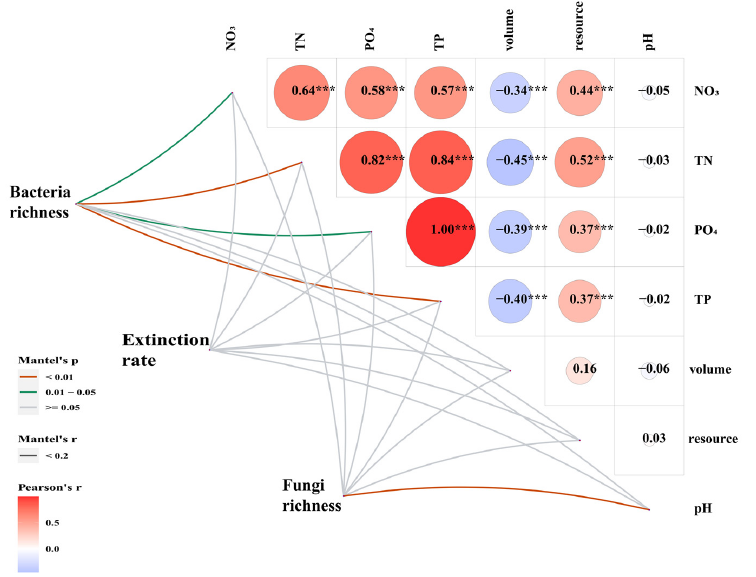
Figure 6. Mantel test correlation plot. The heat map shows the Pearson correlation between the environmental factors; the thickness of the line represents the size of the Mantel test correlation coefficient; the color of the line indicates the p -value of the Mantel test. * p < 0.05, ** p < 0.01, *** p < 0.001. In both treatment groups, microbial taxa with high, medium and low relative abun- dance occurred with high frequency in the less resourceful microcosms (Figure 7). Figure 7. Kernel density diagram of the relationship between resources and relative abundance of microorganisms (fungi and bacteria). In this figure, ( A – C ) are positive groups and ( D – F ) are nega- tive groups; ( A , D ) are microbial taxa with relative abundance greater than 1%, ( B , E ) are microbial